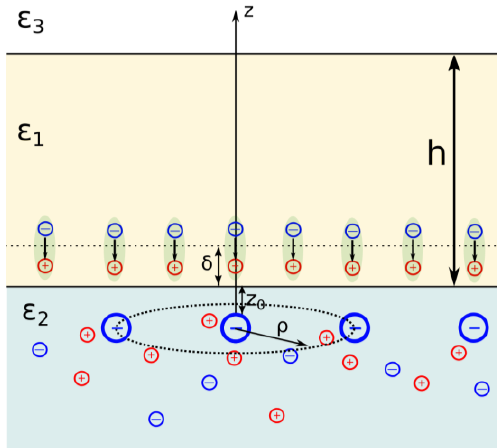
Figure 1. The cylindrical coordinate system coupled with a point charge.